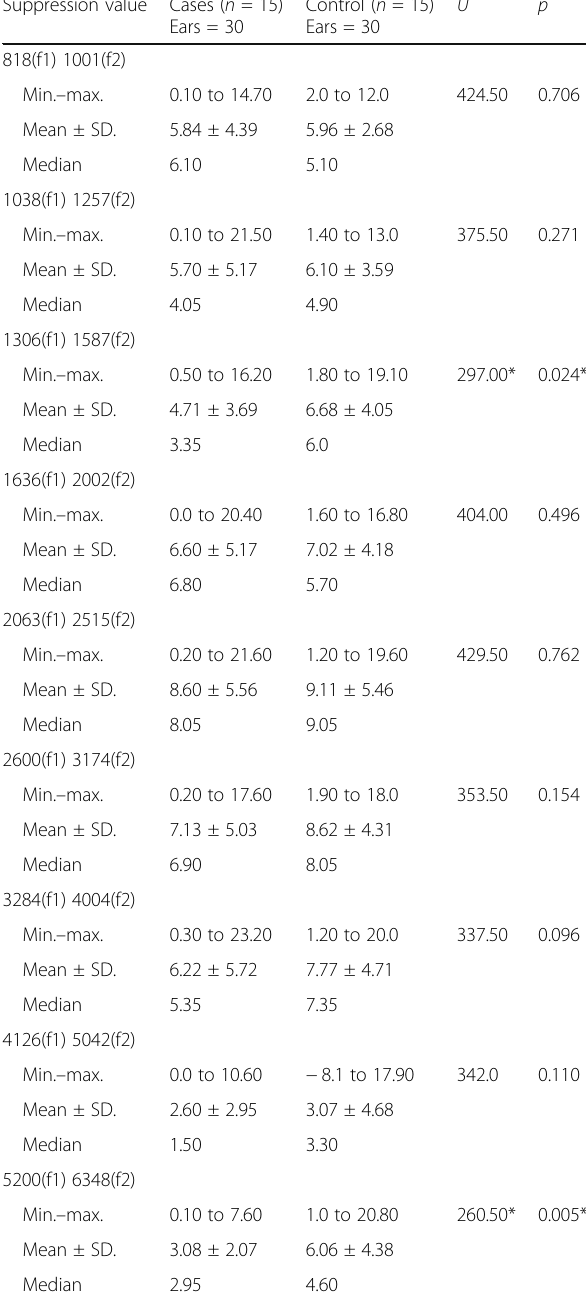
Table 4 TEOAE amplitudes (SNR) in dB SPL in tinnitus patients and control group